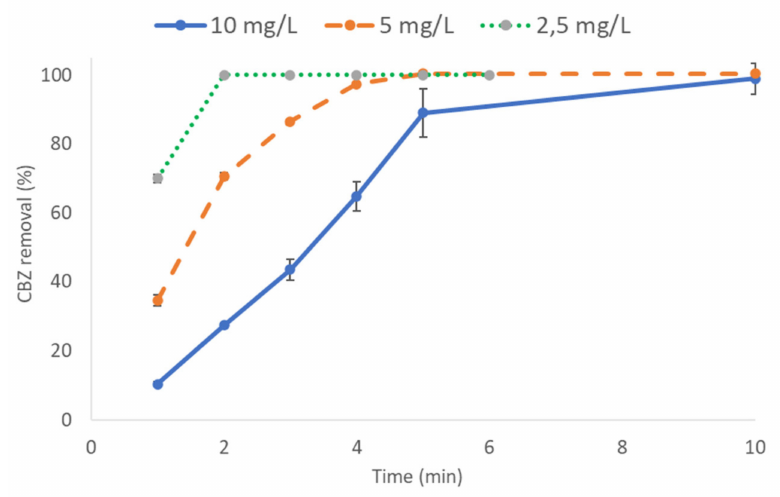
Figure 6. Effect of the initial CBZ concentration on CBZ removal from aqueous solutions (opera- tional conditions: j = 6.67 mA/cm 2 ; NaCl = 0.1 M; pH = 7; reaction time = 10 min; cathode = STS; anode = MMO).